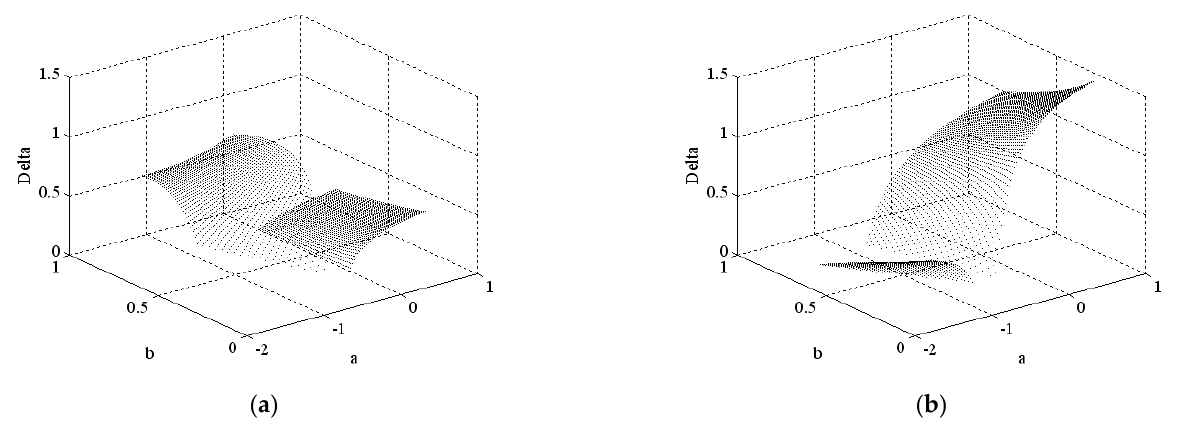
Figure A2. Results for δ (the saddle-focus index) of fixed point O 1 ( a ) and fixed point O 2 ( b ), as functions of control (bifurcation) parameters a ∈ [ − 1.51,1 ] and b ∈ [ 0.29,0.8 ]